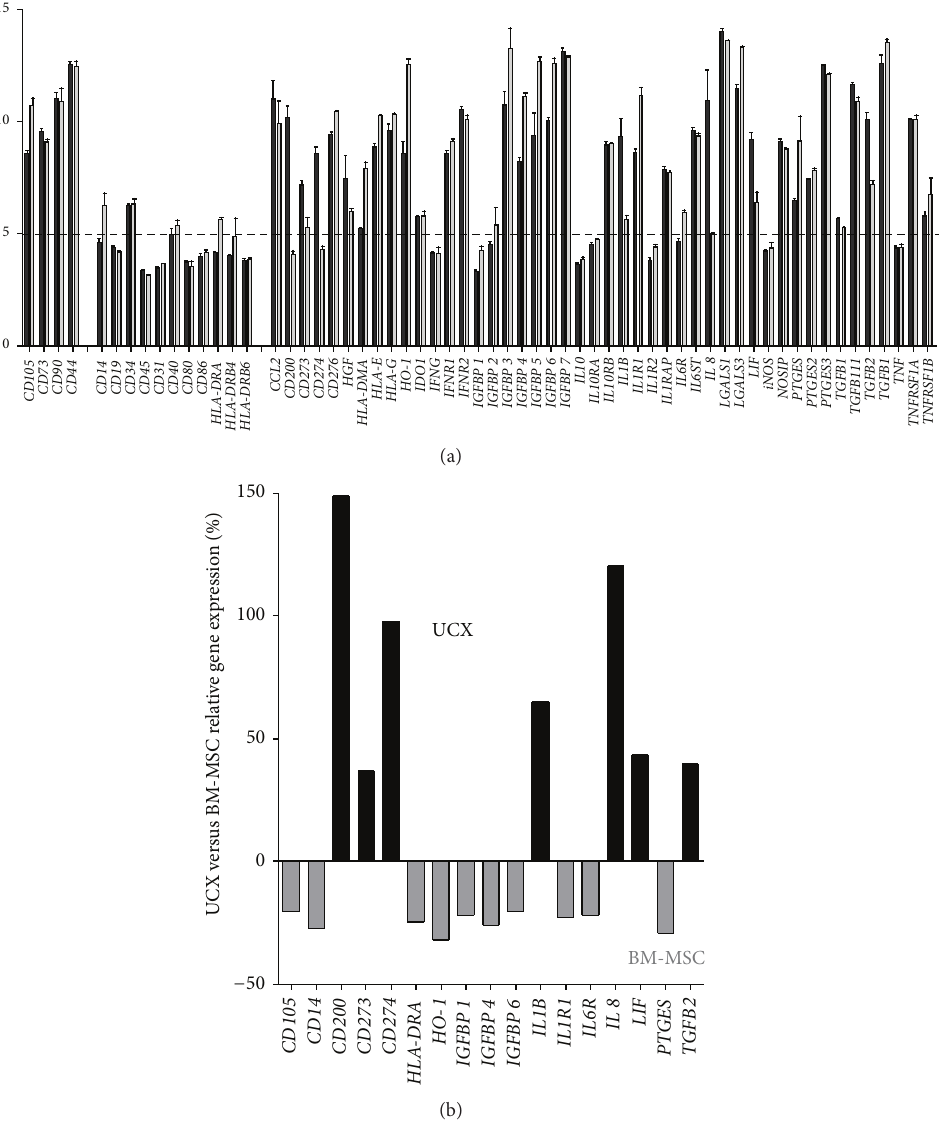
Figure 5: Comparison of UCX (black bars) and BM-MSCs (grey bars) transcriptome of immunomodulatory genes. (a) Relative gene expression of known MSC and immune response related genes in UCX (derived from 3 different umbilical cords) and BM-MSCs (2 different donors) are represented as mean ± s.e.m. Unbroken line was positioned on the average negative known markers of MSCs. Genes with relative expression values above this line were considered substantially expressed. (b) Genes where there was a relative expression significantly increased or decreased 20% or